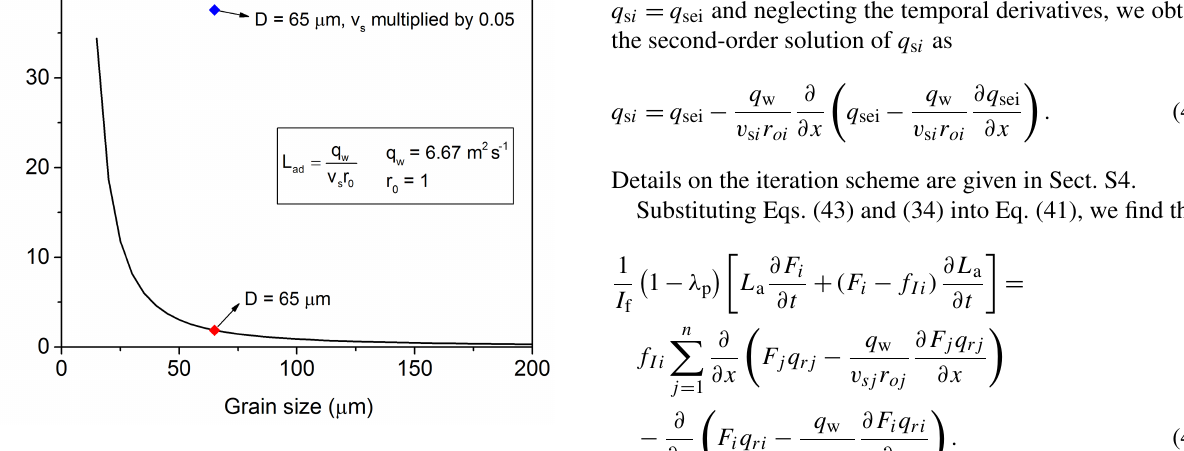
Figure 9. Relation between adaptation length L ad and grain size D . The values of flow discharge per unit width q w and recovery coefficient r 0 are the same as those in Sect. 3.1. The relation of Dietrich (1982) is implemented for sediment fall